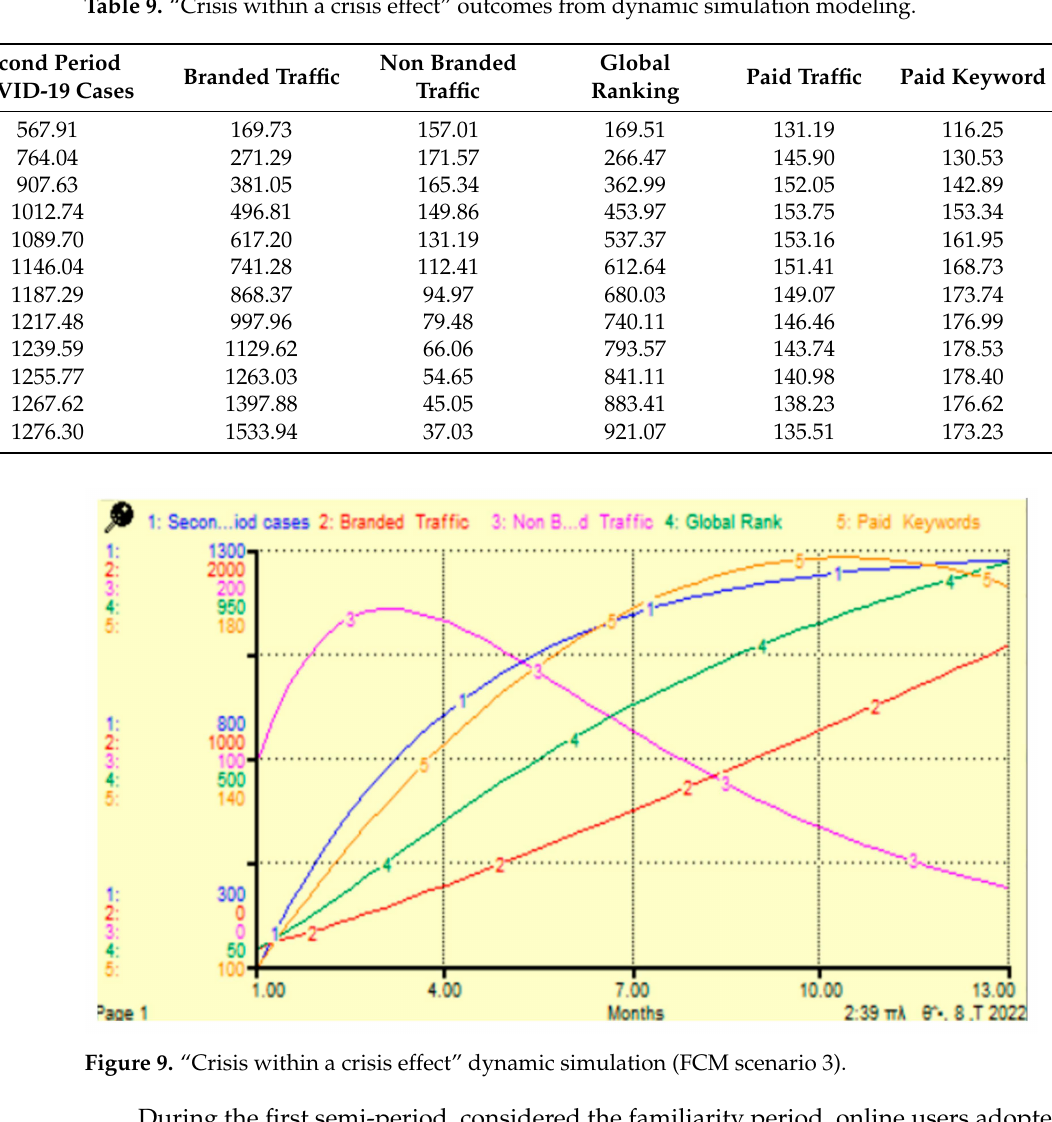
Table 9. “Crisis within a crisis effect” outcomes from dynamic simulation modeling.